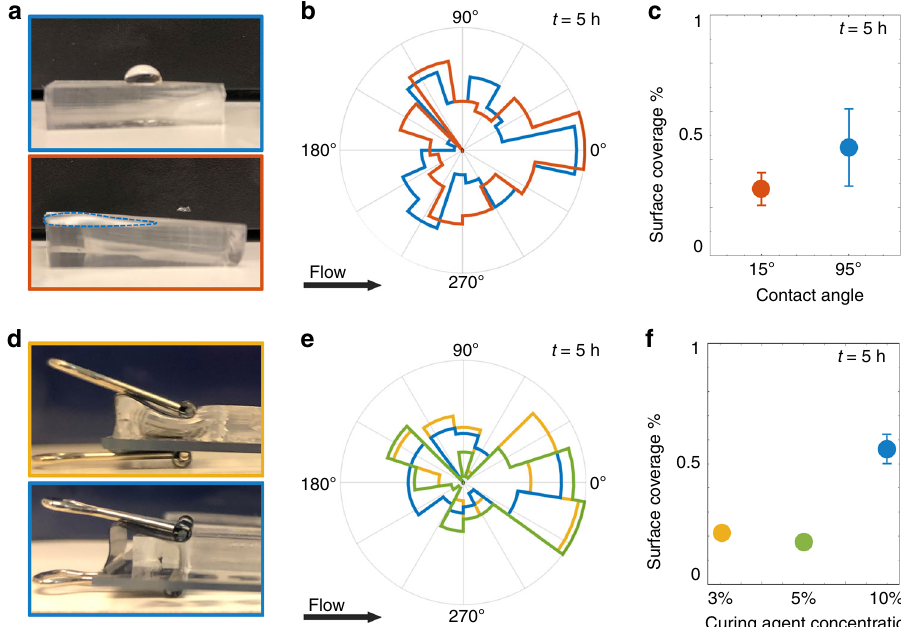
Fig. 6 Surface properties of the pillar do not affect the angular distribution of bacterial colonization. a Behavior of tryptone broth droplets on PDMS surfaces measured 5 days (upper panel; contact angle 95° ± 5°) and 1 h (lower panel; contact angle 15° ± 5°) after plasma treatment showing, respectively, the hydrophobic and hydrophilic nature of the two surfaces. In the lower panel, the droplet wets the surface creating a fi lm: its borders are marked with a blue dashed line in the image for ease of visualization. b Angular distribution of the fl uorescence intensity, I , of PA14 wt GFP cells attached on a hydrophobic pillar (blue) and on a hydrophilic pillar (orange), for a fl ow velocity at U/V = 6.6 and a pillar diameter of 100 µ m. c Surface coverage (measured on the upper surface of the micro fl uidic channel) for the hydrophobic surface (blue) and the hydrophilic surface (orange) under the same experimental conditions as b . d Slabs of PDMS containing 3% curing agent (upper panel; Young modulus = 150 ± 50 kPa) and 10% curing agent (lower panel; Young modulus = 2.25 ± 0.25 MPa) undergoing compression from a binder clip in order to visualize the difference in stiffness. e Angular distribution of the fl uorescence intensity, I , of PA14 wt GFP cells attached on a pillar containing 3% (yellow), 5% (green) and 10% (blue) curing agent, for a fl ow velocity at U/V = 6.6 and a pillar diameter of 100 µ m. f Surface coverage (measured on the upper surface of the micro fl uidic channel) for PDMS containing different concentrations of curing agent under the same experimental conditions as e . Angular distributions and surface coverages were measured after 5 h of continuous fl ow. Error bars correspond to the standard error of the